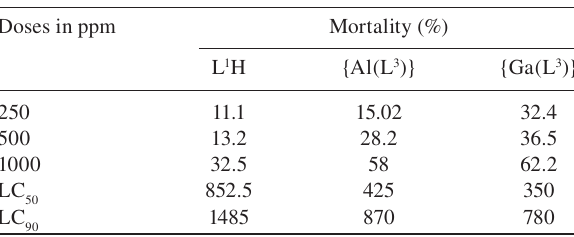
Table 7 Toxicity of ligand L 1 H and its metal complexes against adult males of C. trachypterus (Blanchard).